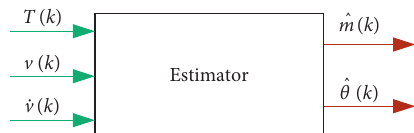
Figure 2: The estimator’s diagram for estimating vehicle’s total mass and pitch